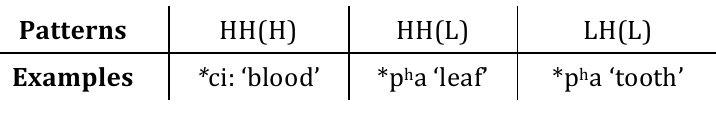
Table 4: Ryukyuan pitch accent in monosyllabic nouns (H = high tone, L = low